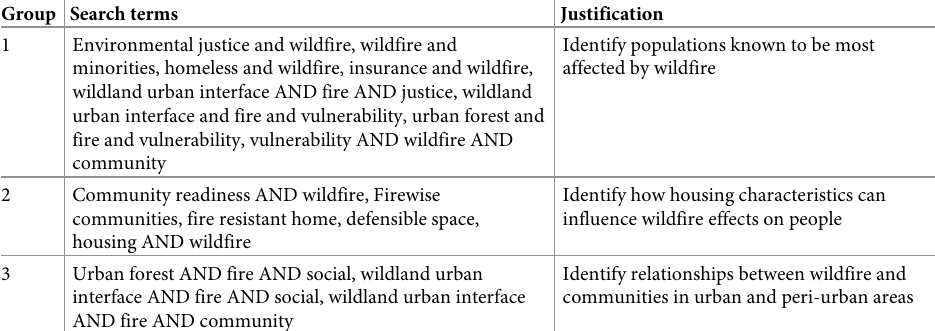
Table 1. Search terms used in the review of the socio-demographic dimensions of wildfires literature using an environmental justice lens. Group Search